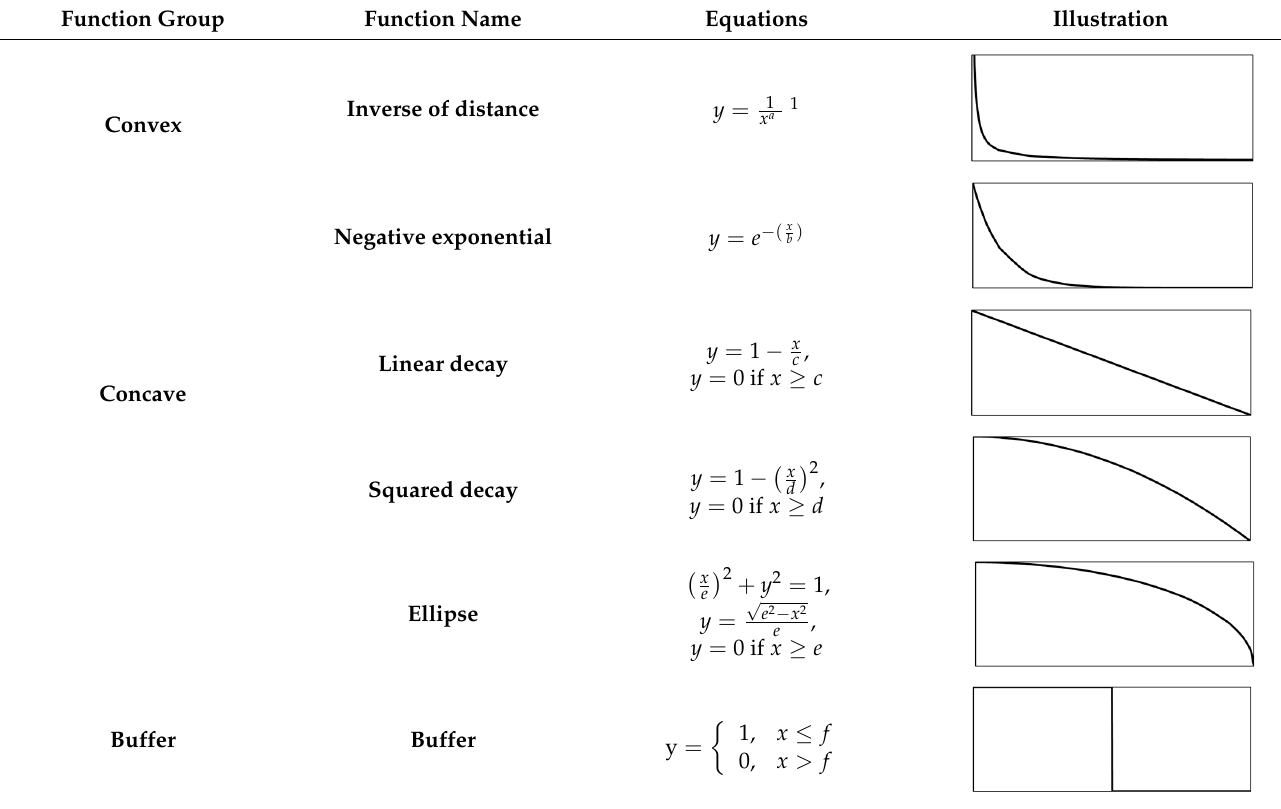
Table 2. List of distance–decay functions tested in this study.